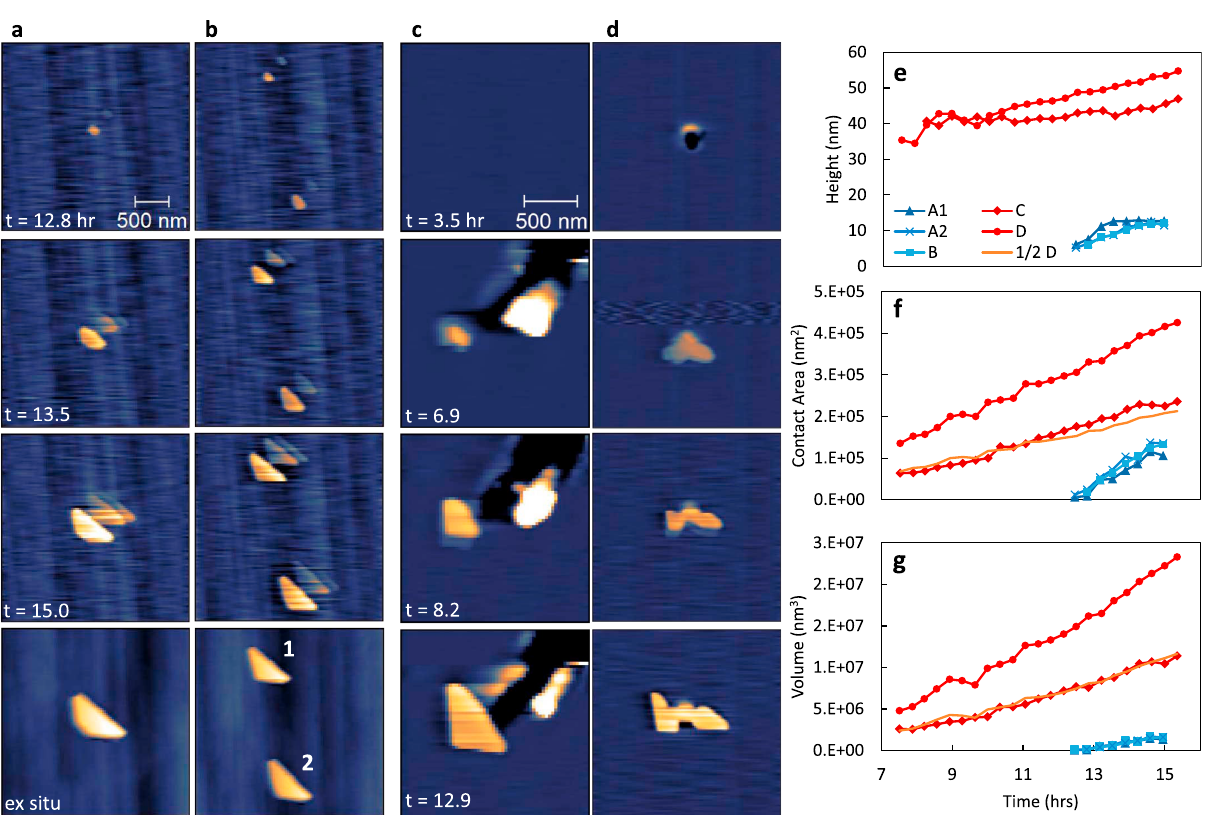
Fig. 3 Time-lapse analysis of X-ray irradiation-induced KNO 3 growth on KBr measured by in situ AFM topography. KBr single crystals were equilibrated for 1 h in 0.1% RH Air ( a , b ) and 60% RH 99% Ar/1% air mix ( c , d ) prior to irradiation at 18 kGy/h. Growth over time of individual KNO 3 crystals shown in ( a – d ) and ½ the value of ( d ) for comparison is measured by height ( e ), contact area ( f ), and volume ( g ). It should be noted that in the dry case the AFM tip shape changed over time, creating a multi-tip artifact. After in situ imaging the tip was replaced to capture the artifact free morphology, a-b last